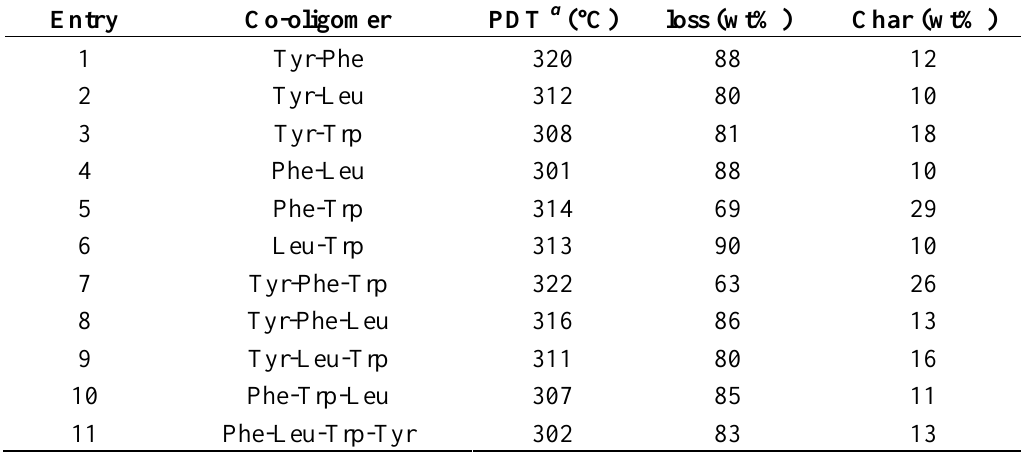
Table 7. Degradation temperatures of the